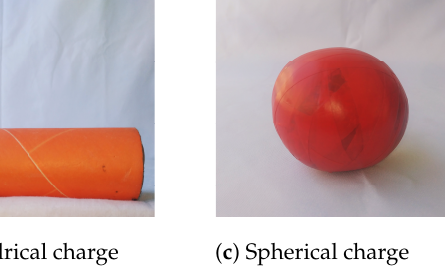
Figure 2. Types of explosive